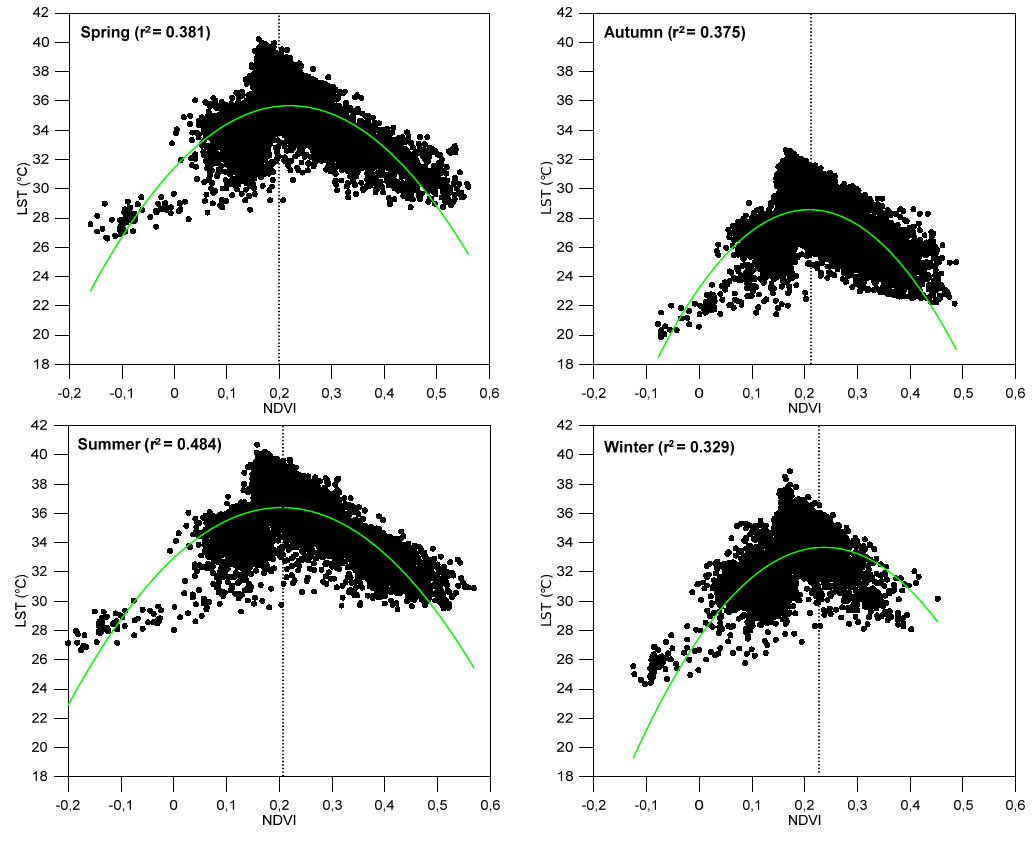
Figure 8. Relationship of Land Surface Temperature with NDVI in the urban buffer. Table 4. Seasonal statistics of LST and NDVI in the urban